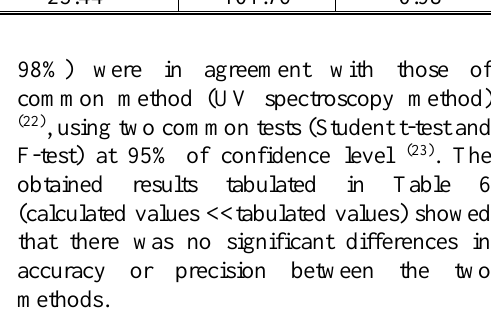
Table 5. Application of the proposed method to the determination of CDE in different dosage forms using standard addition method